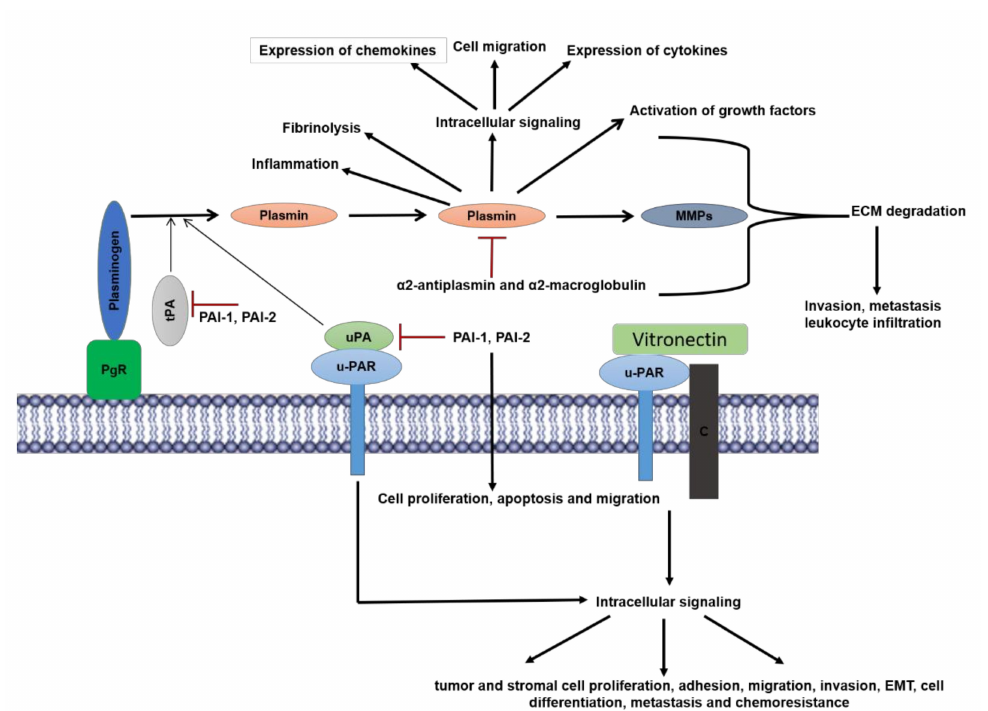
Figure 1. Overview of components and functions of plasminogen-activation system: Plasminogen is activated to the serine protease plasmin by a multicomponent system comprised of plasminogen receptors (PgR), urokinase-type-plasminogen activator (uPA), and tissue-plasminogen activator (tPA). uPA is bound to its receptor urokinase-plasminogen activator receptor (uPAR) whereas in most cases tPA is bound by the PgR. The activity of tPA and uPA are inhibited by the plasminogen-activator-inhibitor 1, 2 (PAI-1, PAI-2), of which PAI-1 is a more potent inhibitor. PAI-1 also promotes cellular proliferation, apoptosis, and migration. Plasmin activity is directly regulated by inhibitors α 2 anti-plasmin and α 2- macroglobulin. Plasmin mediates its physiological effects by virtue of its protease dependent and independent activities.